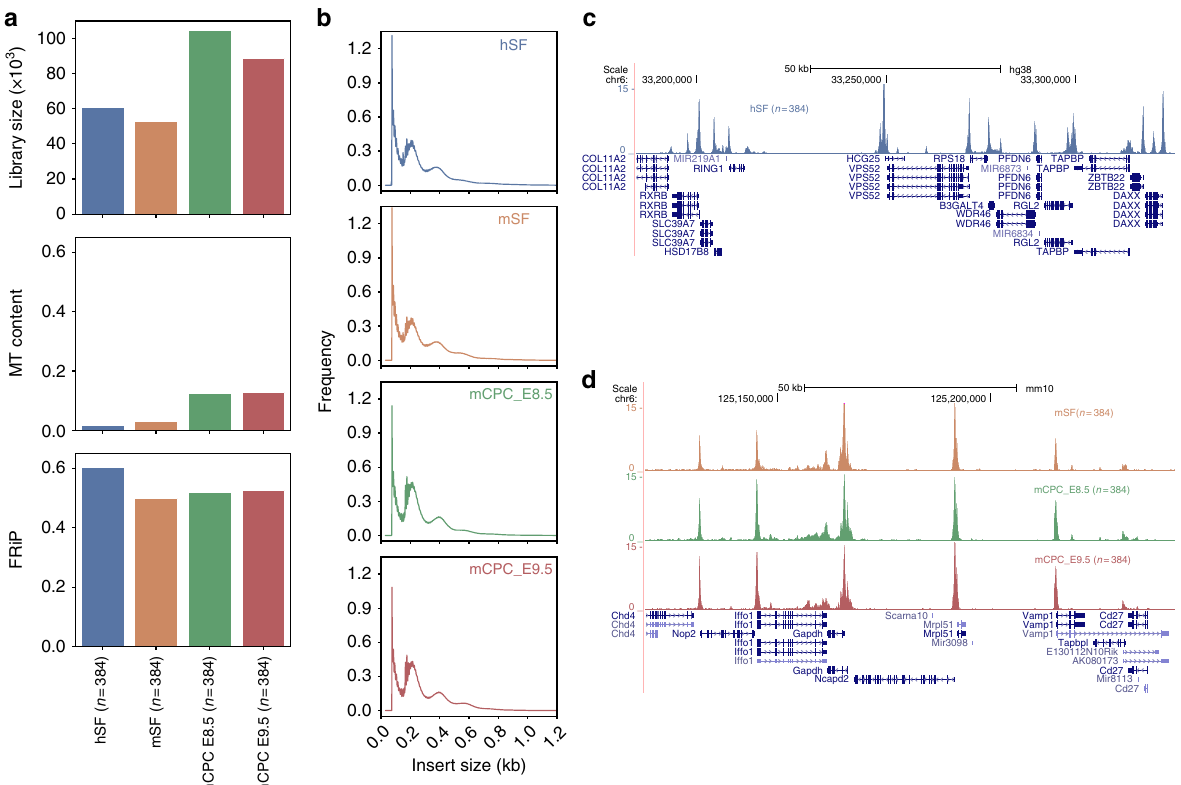
Fig. 2 Plate-based scATAC-seq worked robustly on cryopreserved cells from primary tissues. a Comparison of the median library size (estimated by the Picard tool), fraction of mitochondrial DNA (MT content) and fraction of reads in peaks (FRiP) in cryopreserved single cells from four different tissues: human skin fi broblasts (hSF), mouse skin fi broblasts (mSF), mouse cardiac progenitor cells (mCPC) at embryonic day E8.5 and E9.5. b Insert size frequencies from the aggregated data of the cells from the four tissues. c , d UCSC genome browser tracks displaying the signal around the RPS18 gene locus from the aggregate of hSFs c and around the Gapdh gene locus from the aggregate of mSFs, mCPC_E8.5 and mECP_E9.5